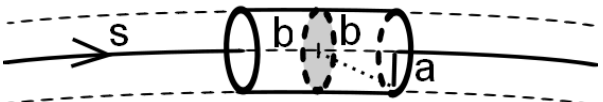
Figure 1: A section of a wire with radius a , with a segment of length 2 b , and a plane perpendicular to the wire axis at the center of the